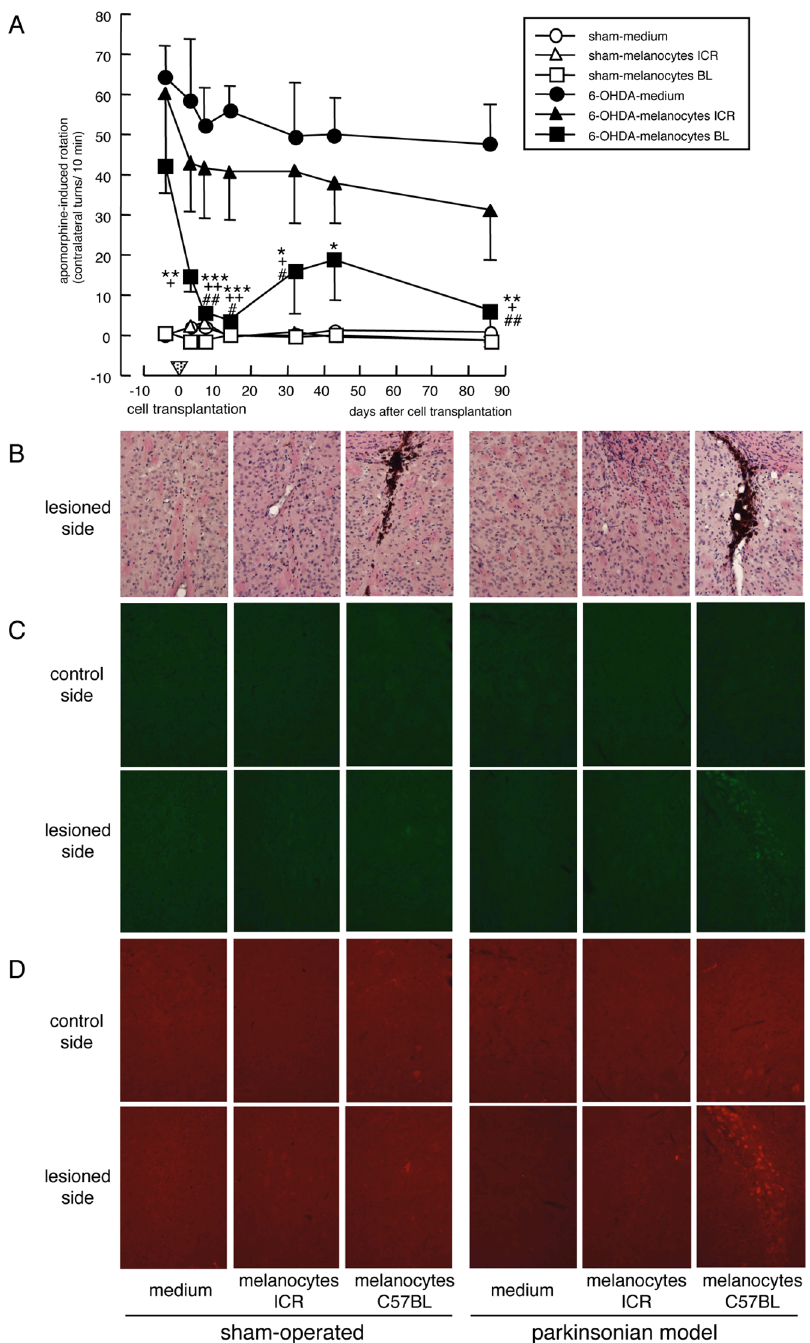
Figure 4. Effects of intrastriatal transplantation of primary cultured melanocytes in hemi-parkinsonian mice. Melanocytes from albino (ICR) or black (BL) mice suspended with medium (3 6 10 5 cells/2 m l) were transplanted into the right lateral striatum of hemi-parkinsonian albino mice and sham-operated controls at 48 days after 6-OHDA lesioning. (A) Asymmetric rotation behavior towards contralateral side over 10 min after injection of apomorphine (0.5 mg/kg, s.c.) was recorded at 3–86 days after melanocyte transplantation. Values are means 6 SEM of 3–4 mice. *p , 0.05, **p , 0.01, ***p , 0.001 vs. each 6-OHDA-medium, + p , 0.05, ++ p , 0.01 vs. each 6-OHDA-melanocytes ICR, # p , 0.05, ## p , 0.01 vs. each pre- transplantation of melanocytes. Histological changes in the striatal area around the transplant after intrastriatal melanocyte transplantation into hemi-parkinsonian mice. Hematoxylin-eosin-staining (B), tyrosinase-positive IR (C), and DA-positive IR (D) in the right lateral striatum around the transplant of hemi-parkinsonian albino mice and sham-operated controls at 88 days (12 weeks) after intrastriatal transplantation of melanocytes obtained from albino (ICR) or black (C57BL) mice.